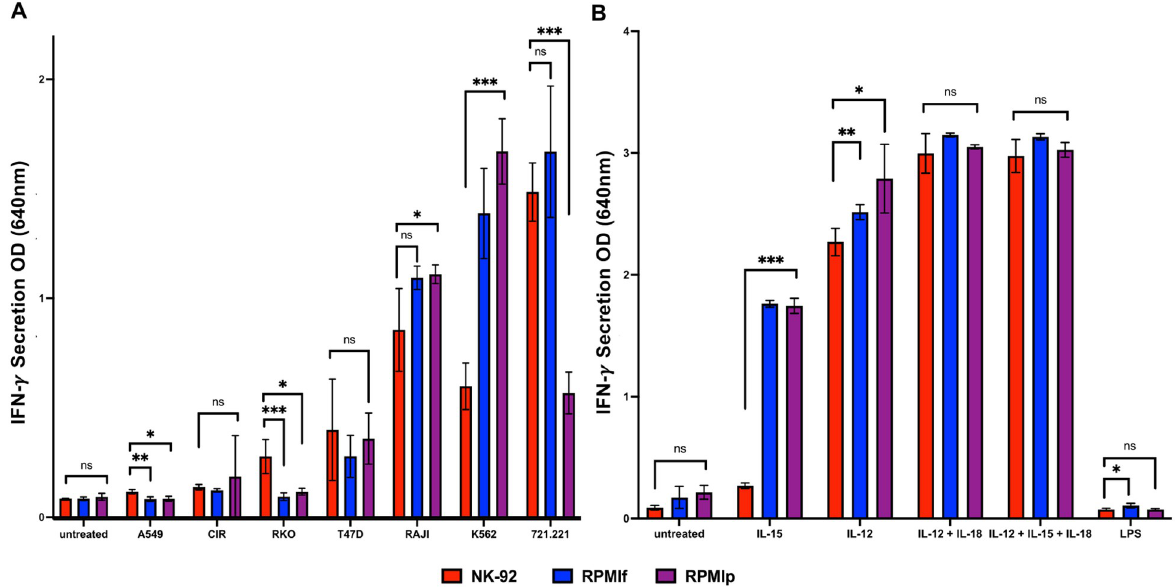
Fig 3. Comparison of secretory potential after activation of NK-92 cells in different growth conditions. A) + B) Secretion of IFN- γ ; A) Secretion after activation with tumor cells for 48h at 37˚C (721.221, A549, C1R, K562, RAJI, RKO, T47D), B) Secretion after activation with interleukins after 48h of incubation at 37˚C (IL-12, IL-15, IL-12 + IL-18, IL-12 + IL-15 + IL-18, LPS); red = NK-92med ., blue = RPMIf , violet = RPMIp . � p < 0.05, �� p < 0.005, ��� p < 0.001 compared between the NK-92 in NK-92 medium as control and the NK-92 in RPMI + IL-2 medium (two-tailed ANOVA test + multiple unpaired T-tests). Shown is 1 representative out of 5 assays performed.